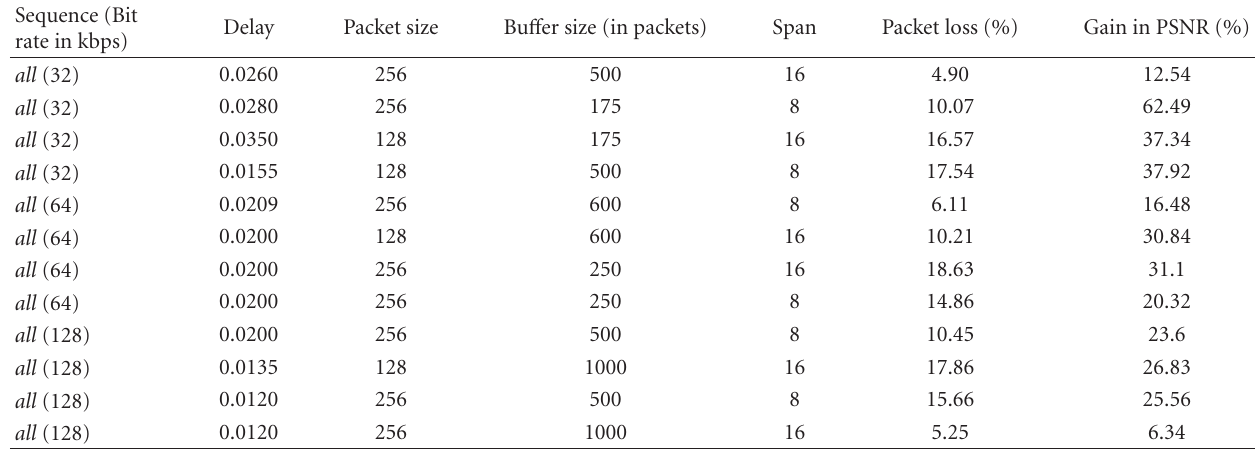
Table 4: Performance comparisons for all at di ff erent rates and proxy